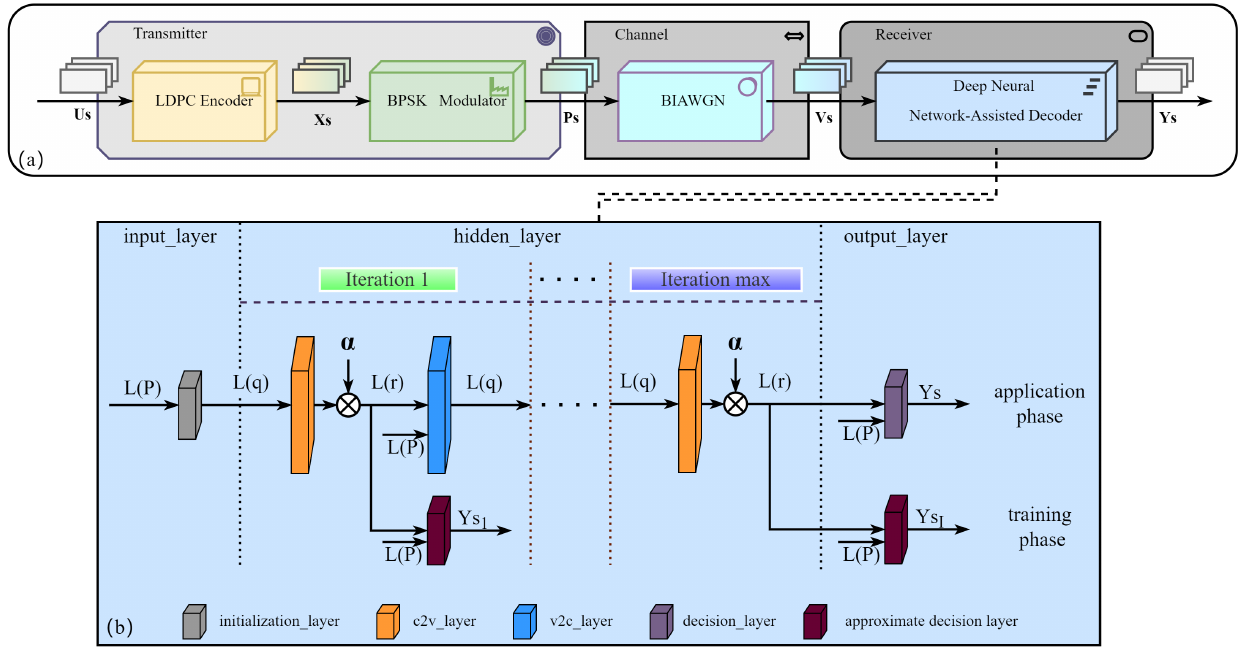
Figure 6. The proposed deep neural network-assisted decoder (DNNAD). ( a ) The general model of the simulation system based on the DNNAD. ( b ) The network structure of the DNNAD. The structure has not changed in the application phase, but some weights are added to the forward propagation. In the training phase, we add some additional branches to output the decoded codewords of each iteration based on the original network structure, so the number of hidden layers becomes ( 3 I − 2 ) , where I is the maximum number of